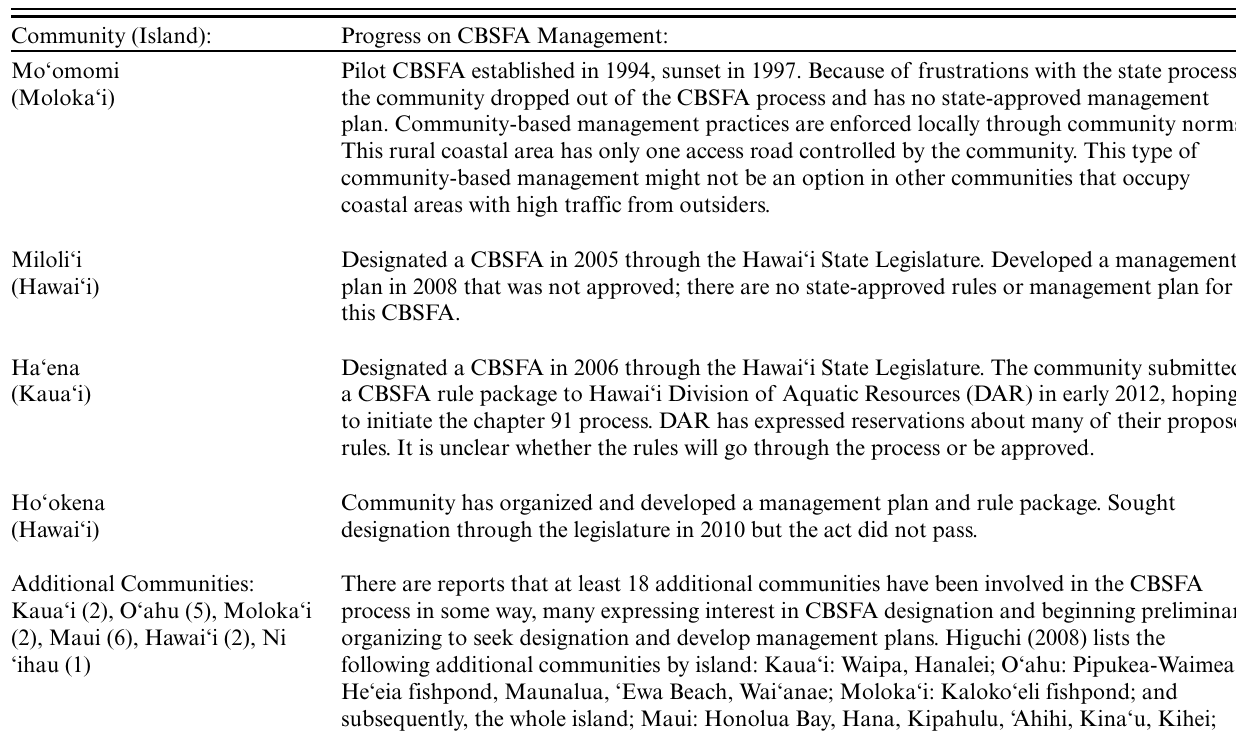
Table 1 . Communities involved in the Community-Based Subsistence Fishing Area (CBSFA) process and their progress with CBSFA designation and management in their coastal